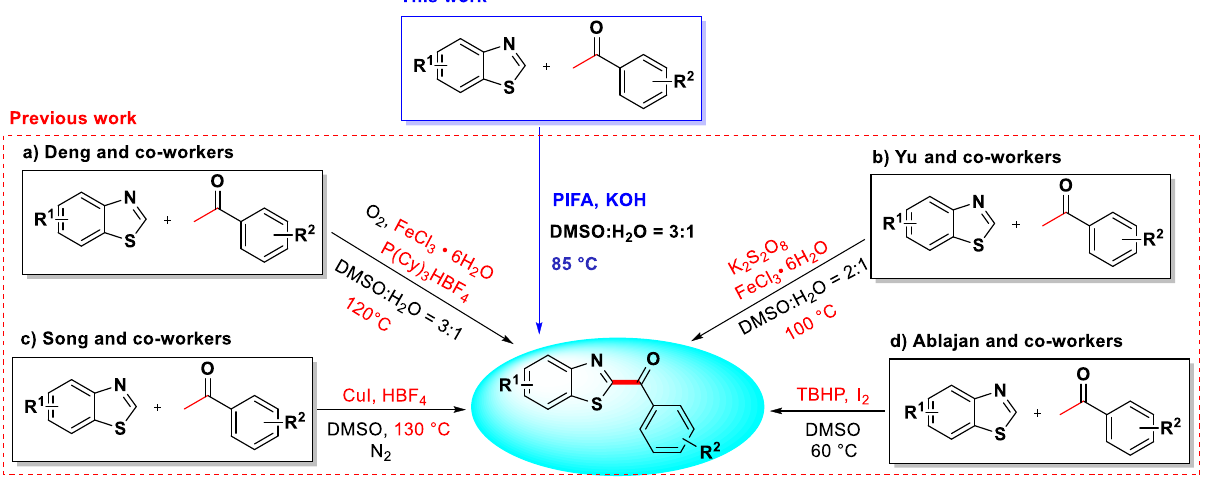
Figure 2. Representative arylacylation reactions of 2H -benzothiazoles.